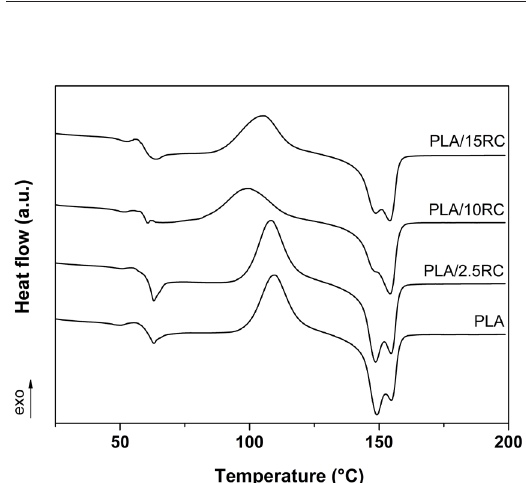
Figure 8. First heating DSC curves of the injection molded